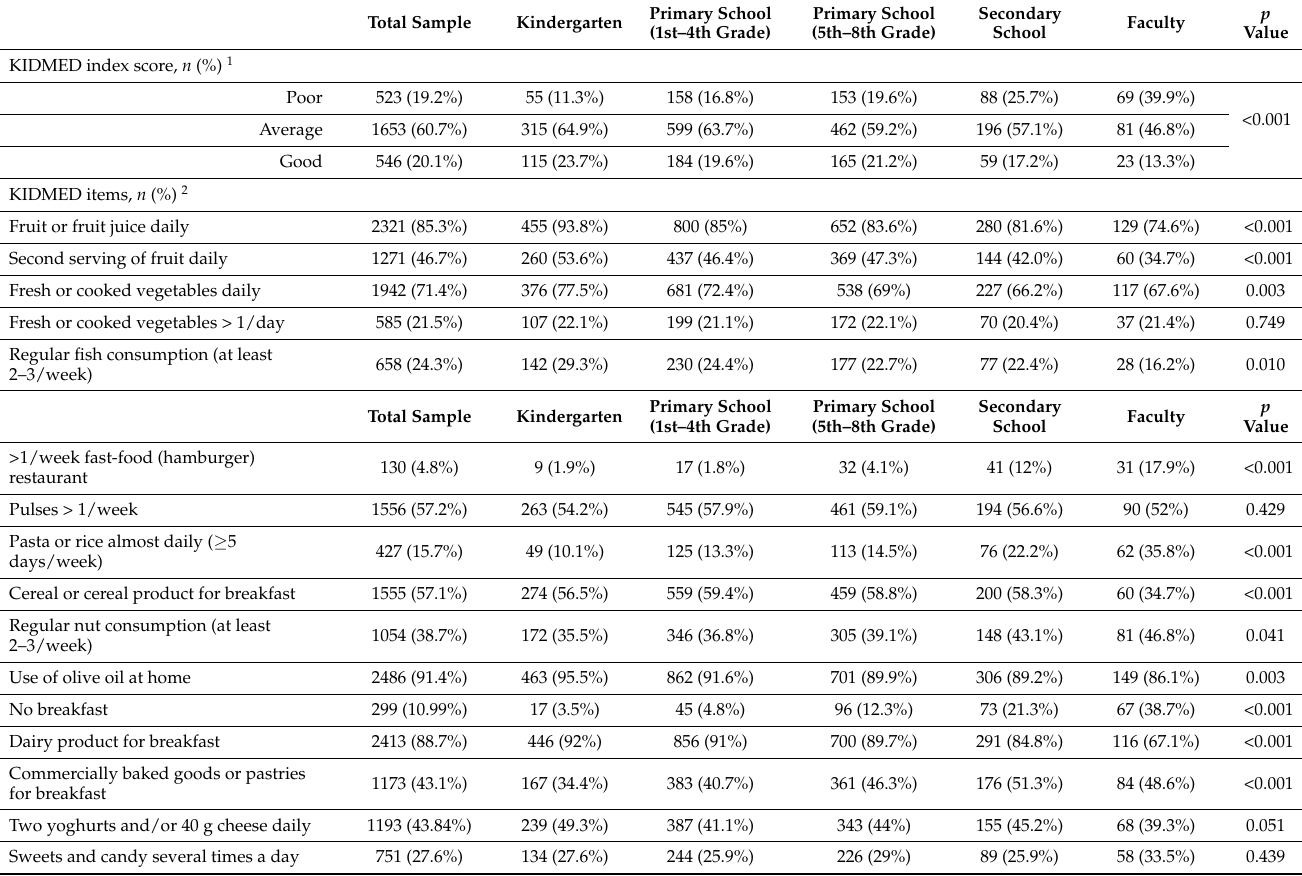
Table 2. Results of the KIDMED test according to educational stage.